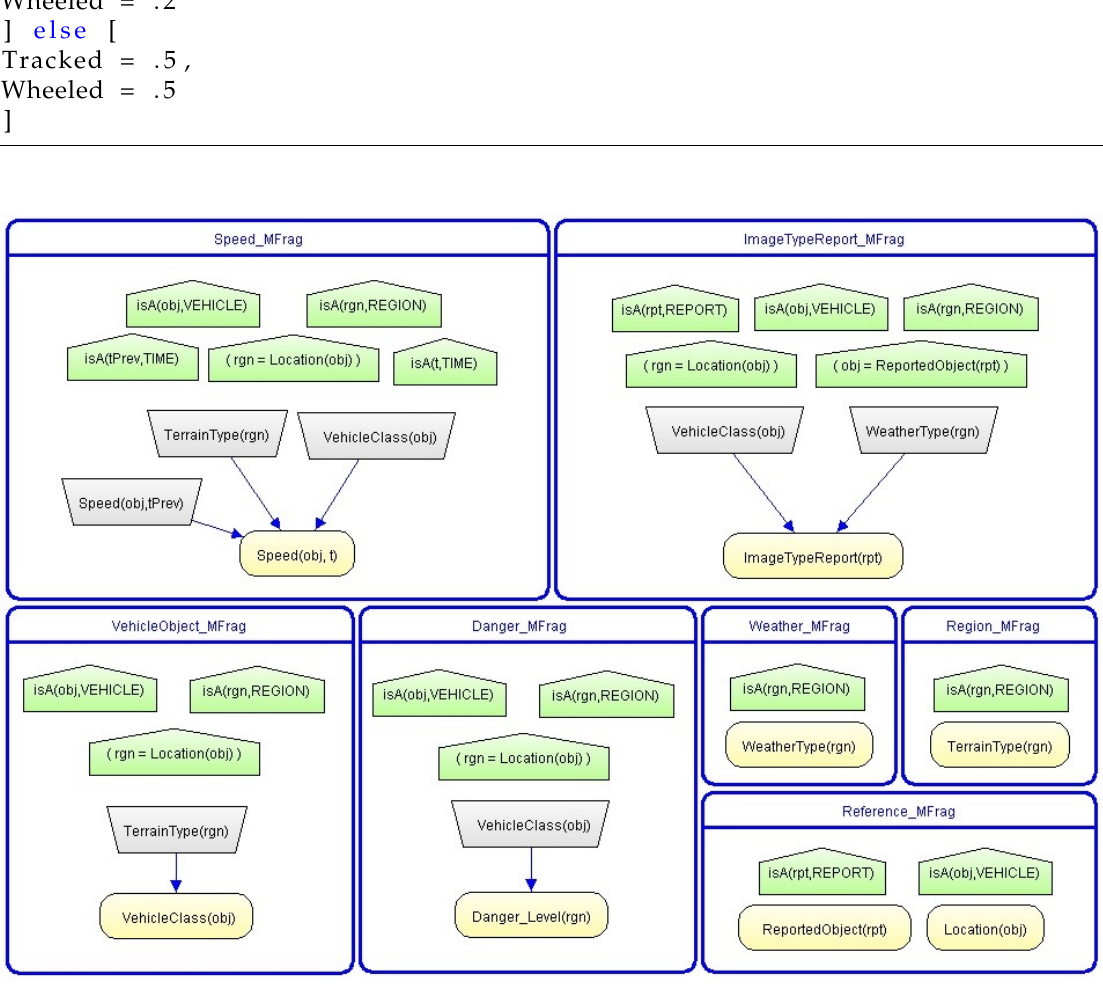
Figure 1. Danger Assessment